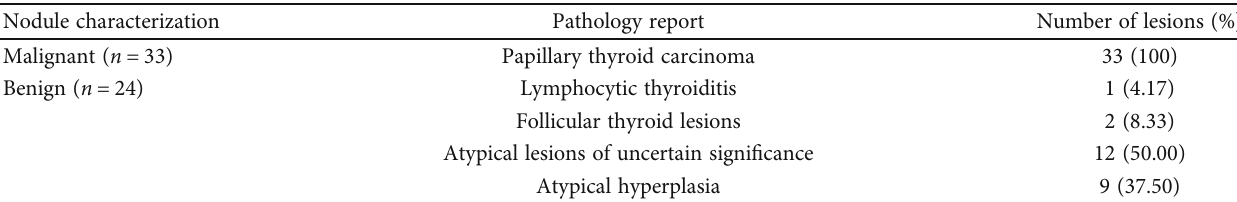
Figure 1: Work fl ow of patient selection. Table 1: Biopsy results [ n ð % Þ ].